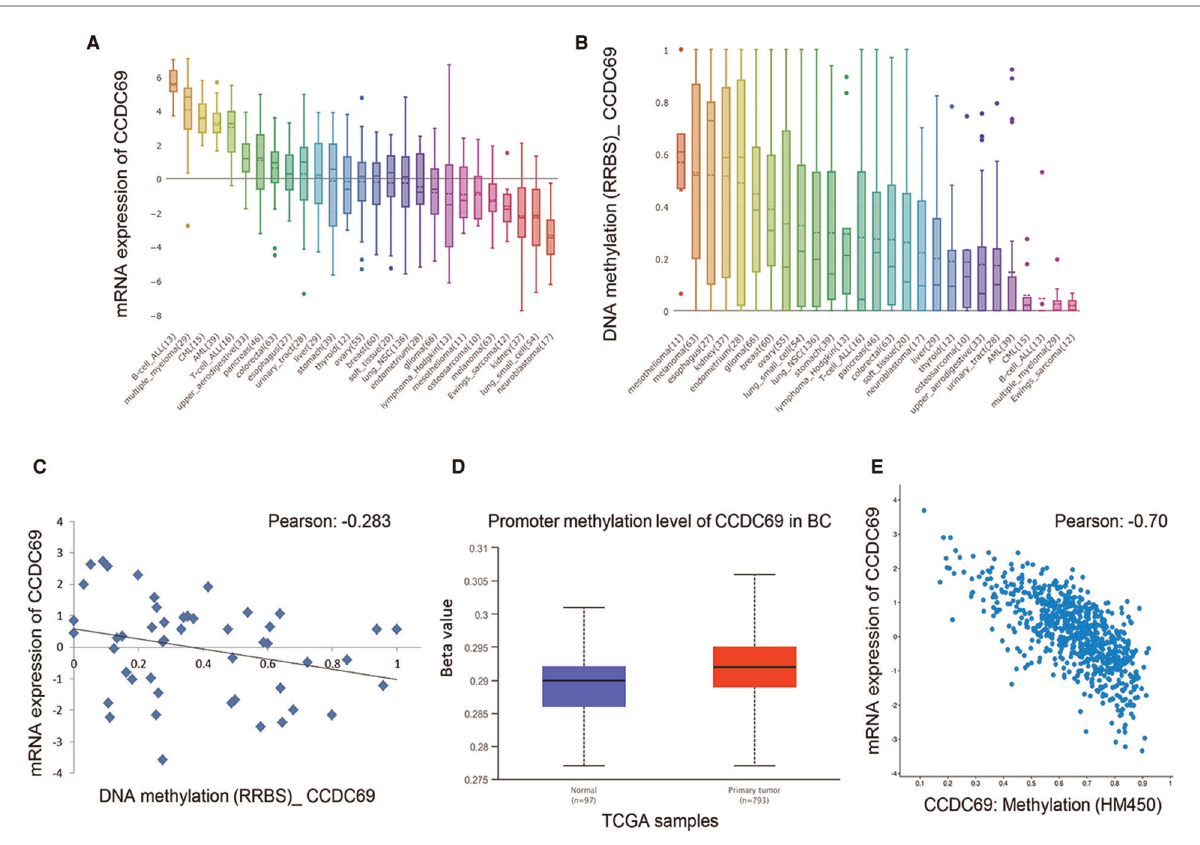
FIGURE 9 The expression level of CCDC69 was affected by the methylation level of its promoter region. ( A ) The expression of CCDC69 in various cancer cell lines. ( B ) Levels of DNA methylation in various cancer cell lines. ( C ) DNA methylation was negatively correlated with CCDC69 expression in 48 BC cell lines. ( D ) In the UALCAN database, the promoter methylation level of the breast cancer sample CCDC69 was higher than that of normal tissues. ( E ) Analysis of Bioportal data indicated that the expression level of CCDC69 was negatively correlated with the methylation level of the promoter